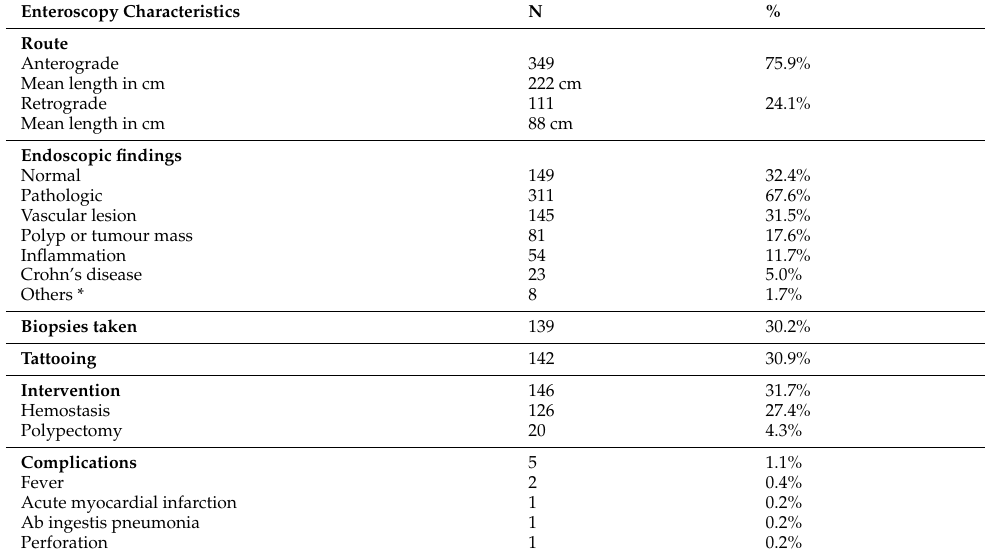
Table 1. Characteristics, diagnostic yield, therapeutic yield and complications of double-balloon- assisted